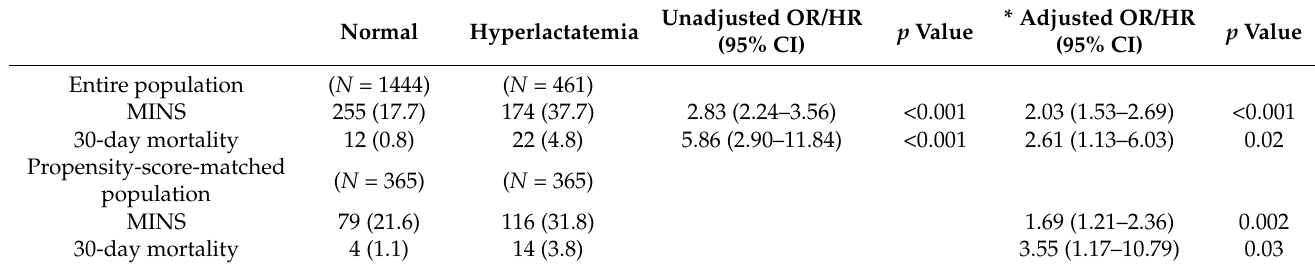
Table 2. The incidence of myocardial injury after noncardiac surgery according to intraoperative hyperlactatemia.